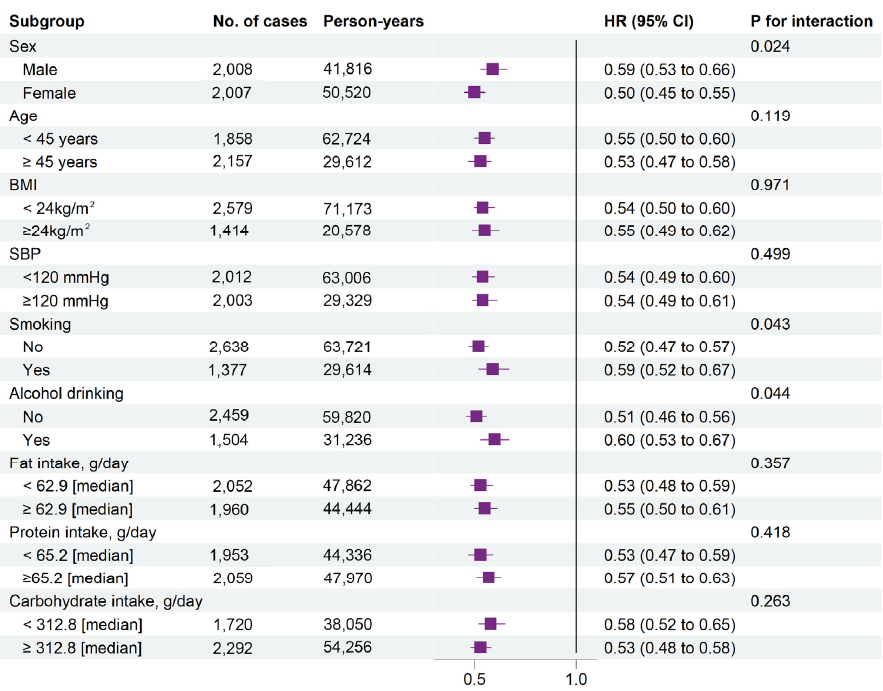
Figure 2. Stratified analyses by potential effect modifiers for the association between dietary tomato intake and new-onset hypertension in various subgroups. Adjusted, if not stratified, for age at baseline (continuous), sex (male/female), BMI (continuous), smoking (yes/no) and drinking status (yes/no), education (middle school or below, high school or college or above), residence (urban or rural), marital status, physical activity (continuous), as well as cumulative average vegetable (continuous), fruit (continuous), and energy intake (continuous). p interaction was calculated using the likelihood ratio test. Abbreviations: BMI, body mass index; CI, confidence interval; DBP, diastole blood pressure; HR, hazard ratio; SBP, systolic blood pressure.